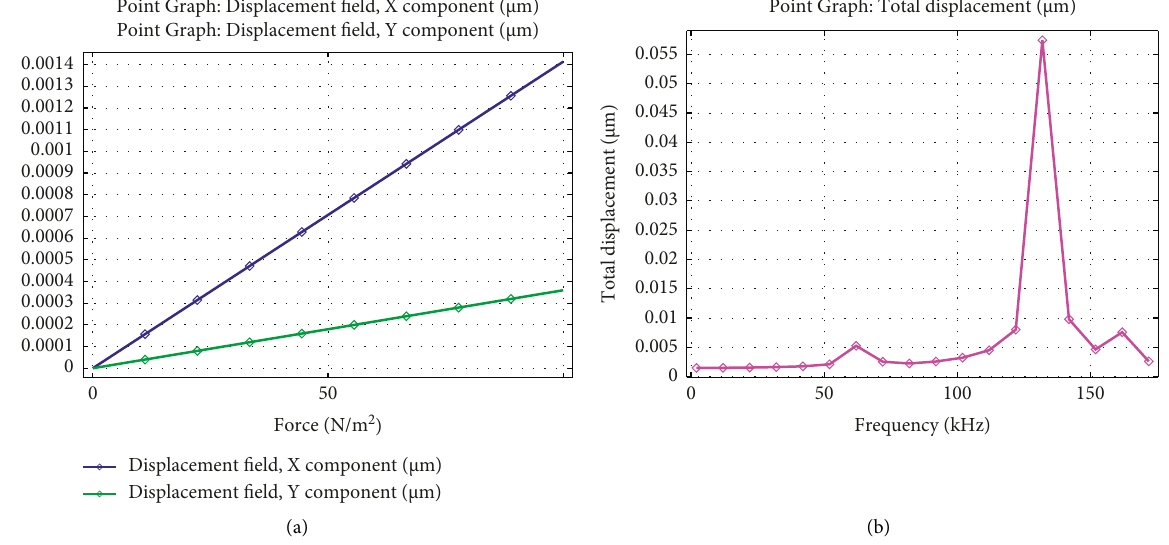
Figure 12: (a) Displacement characteristics; (b) natural frequency for the proposed sensor